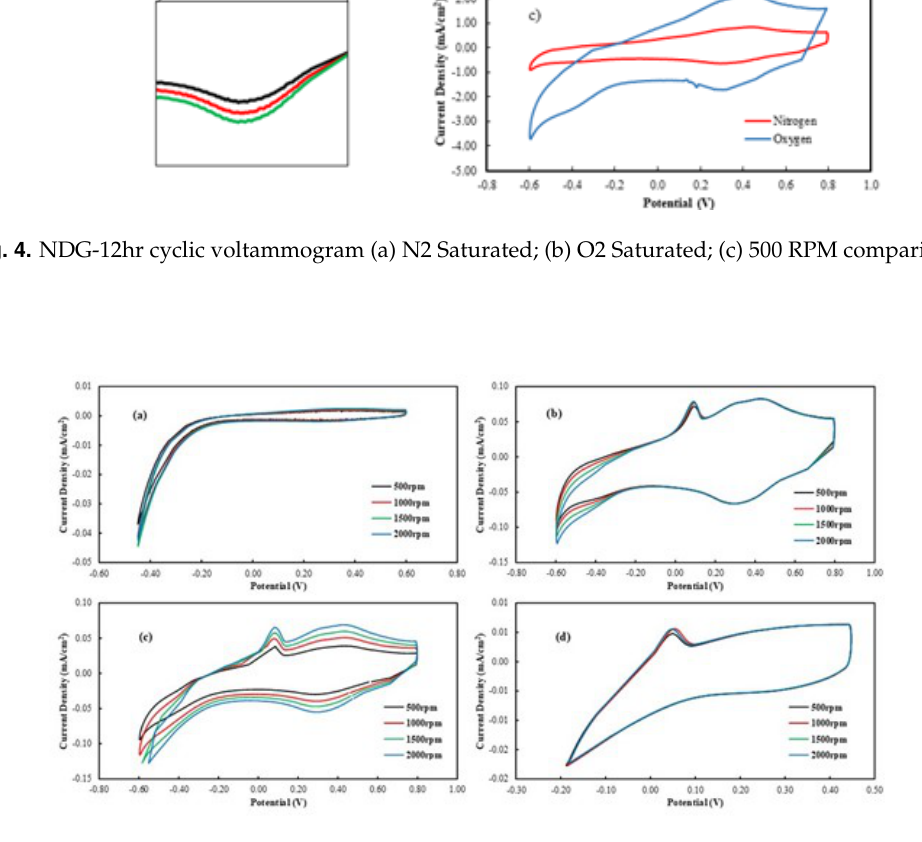
Fig. 5. Cyclic voltammogram in N 2 saturated. (a) NDG-0.5hr; (b) NDG-2hr; (c) NDG-4hr; (d) NDG-50hr.